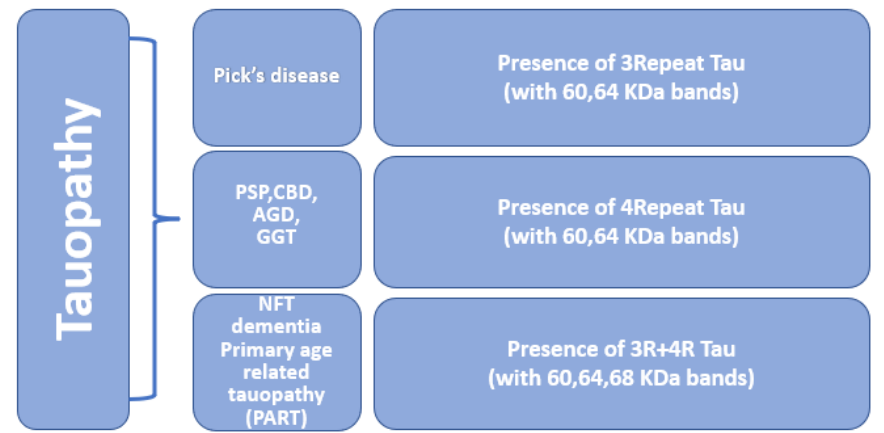
Figure 5. Molecular classification of primary tauopathy. Tauopathies are divided into three categories based on the presence of repeat isoforms. 3-repeat tauopathy is linked with Pick’s disease. The presence of 4-repeat isoforms is linked with PSP, CBD, AGD, and GGT. The presence of both 3-repeat and 4-repeat tau isoforms is associated with primary age-related tauopathy and tangles-only dementia.